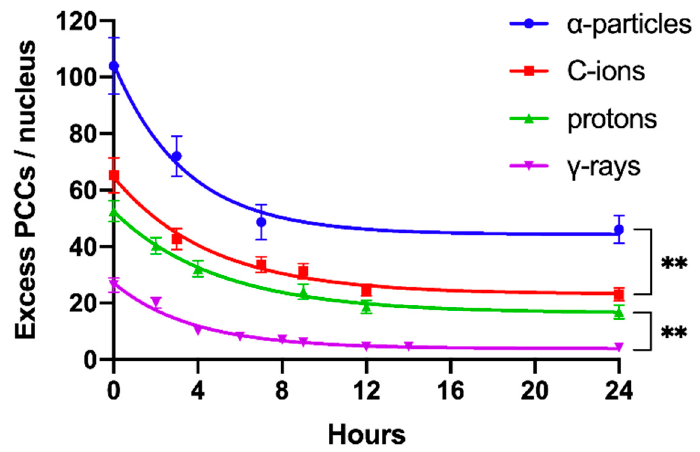
Figure 6. Repair kinetics of the initial DNA lesions induced by 6 Gy of different radiation qualities as reflected in G0 lymphocyte PCCs and constructed by means of excess PCC fragments per nucleus at various repair times up to 24 h. Based on this cytogenetic endpoint of residual lesions at 24 h repair time, the derived RBE values were 10.7 for α -particles, 5.4 for C-ions and 3.9 for protons. (Mean ± SD based on three independent experiments; n ≥ 50 cells analyzed per experimental point; ** p ≤ 0.01).